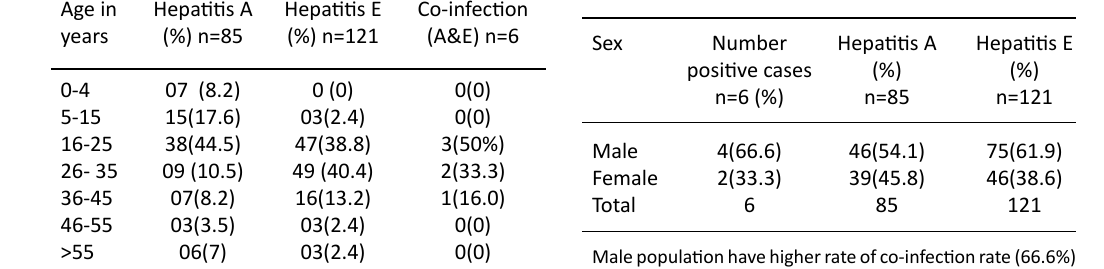
Table 2. Age specific etiology of acute viral hepatitis Table 3. Sex distribution of CO- infection, HAV and HEV in patients presenting acute viral hepatitis